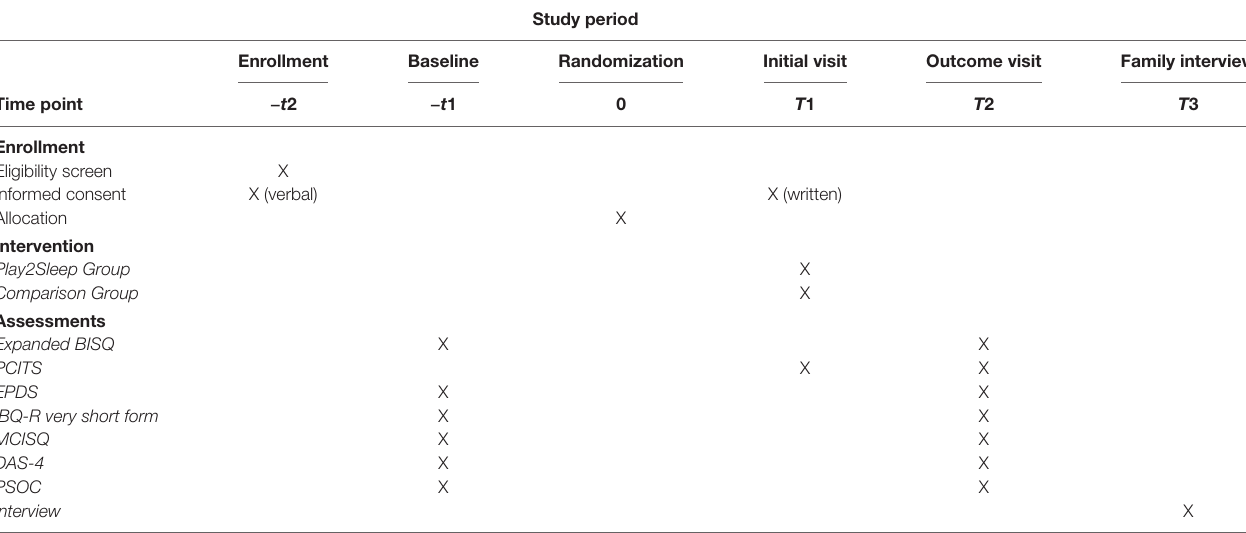
taBlE 4 | Play2sleep study schedule of enrollment, interventions, and assessments